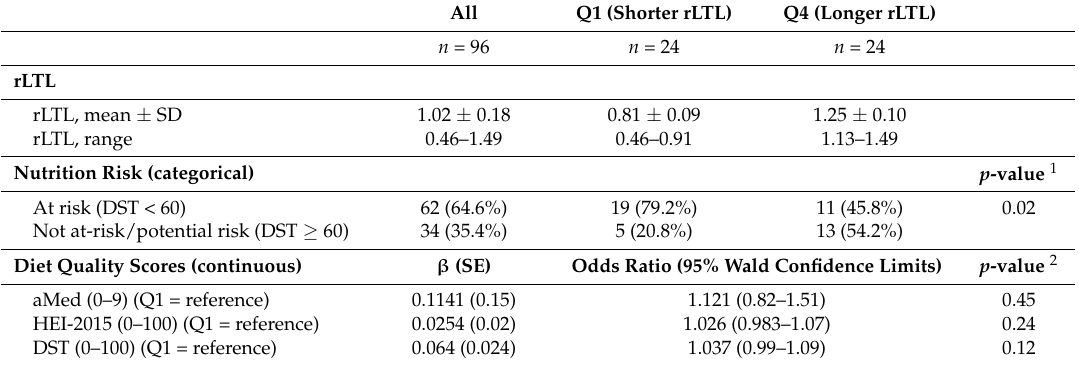
Table 2. Cross classification of diet quality scores by relative leukocyte telomere length